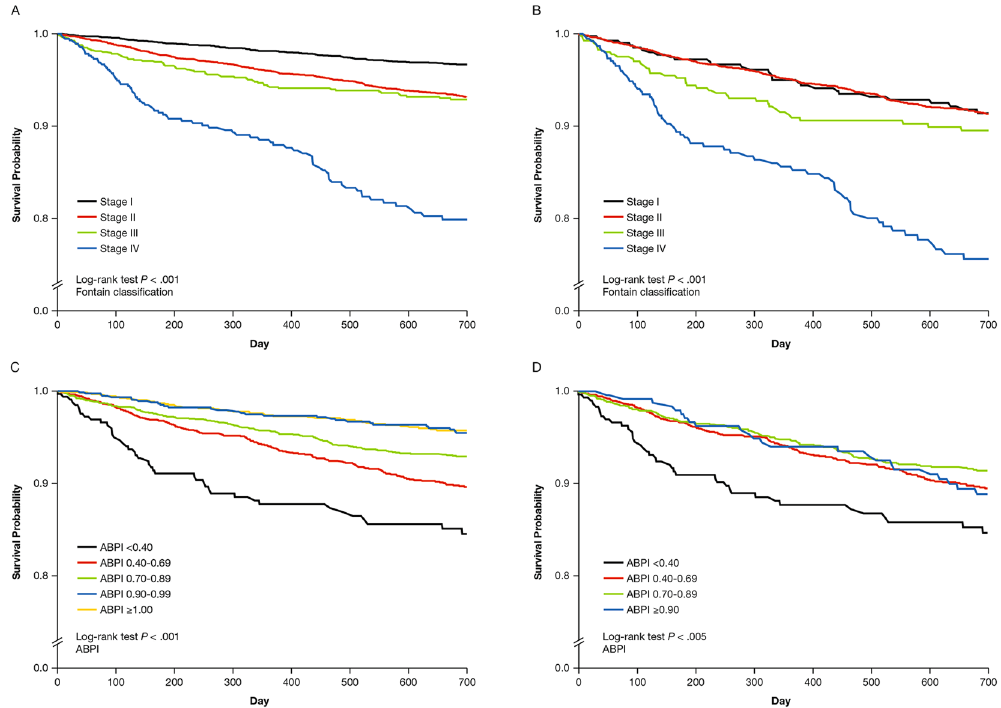
Figure 2. Kaplan-Meier Curves for Composite Events Over 2 Years (RWP and DPP) Composite events in ( A) the RWP by Fontaine classification at baseline, ( B) the DPP by Fontaine classification at baseline, ( C) the RWP by ABPI classification at baseline, and ( D) the DPP by ABPI classification at